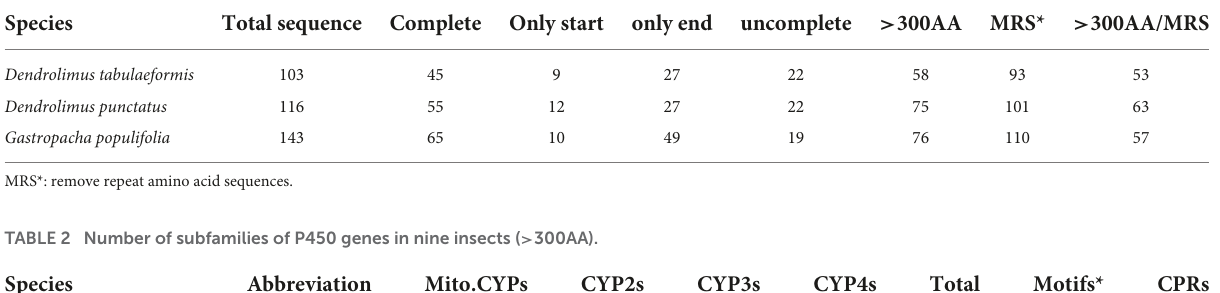
TABLE 1 Statistical results of completeness of P450.